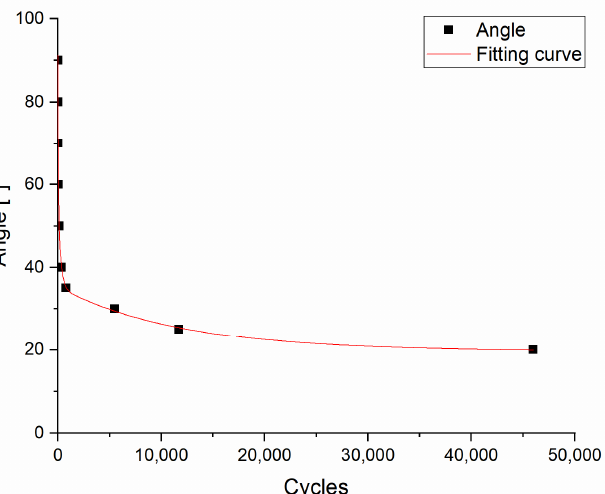
Figure 7. Results of torsion fatigue testing of PLA. Fracture points of test specimens with different rotation values. The black squares indicate the angle (°) and the number of cycles within which the fracture took place.